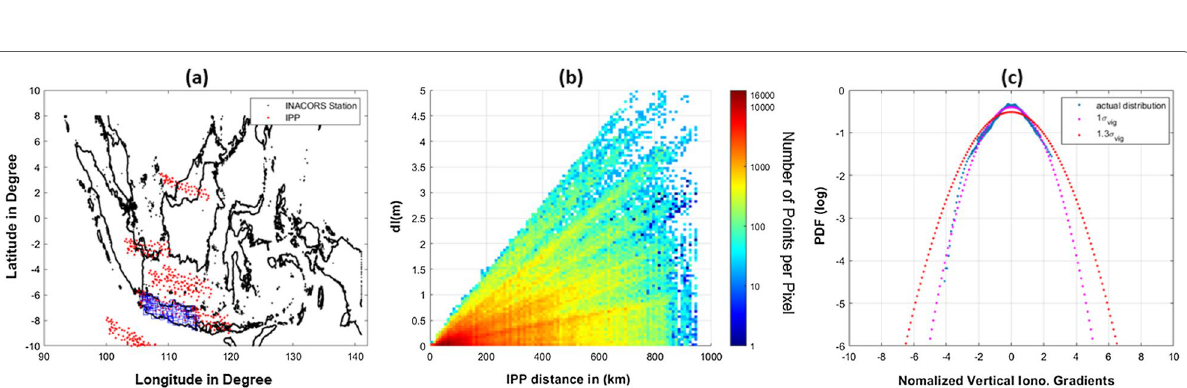
Fig. 6 a CORS location (blue) and their IPPs (red) on Java island used in the NeQuick model; b ionospheric delay difference as a function of the IPP distance; c PDF of the normalized ionospheric gradient generated by the NeQuick model